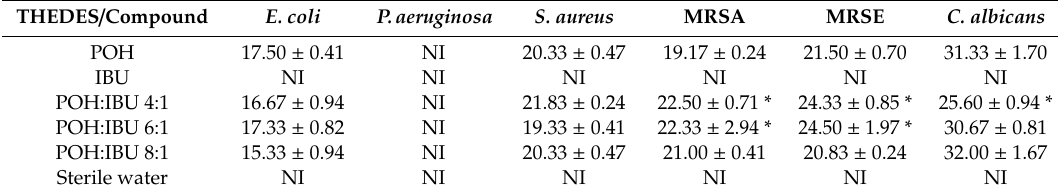
Table 2. Inhibition halo measurements (diameter (mm) ± SD) for the various THEDES formulations, individual counterparts and controls α . Results are presented by formulation / compound for each microbial strain tested. NI—no inhibition; NT—not